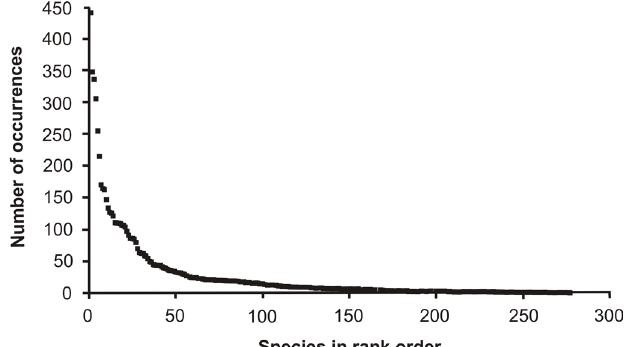
Fig 1 . Diversity-abundance curve of all ant species collected at the Panga Ecological Station.